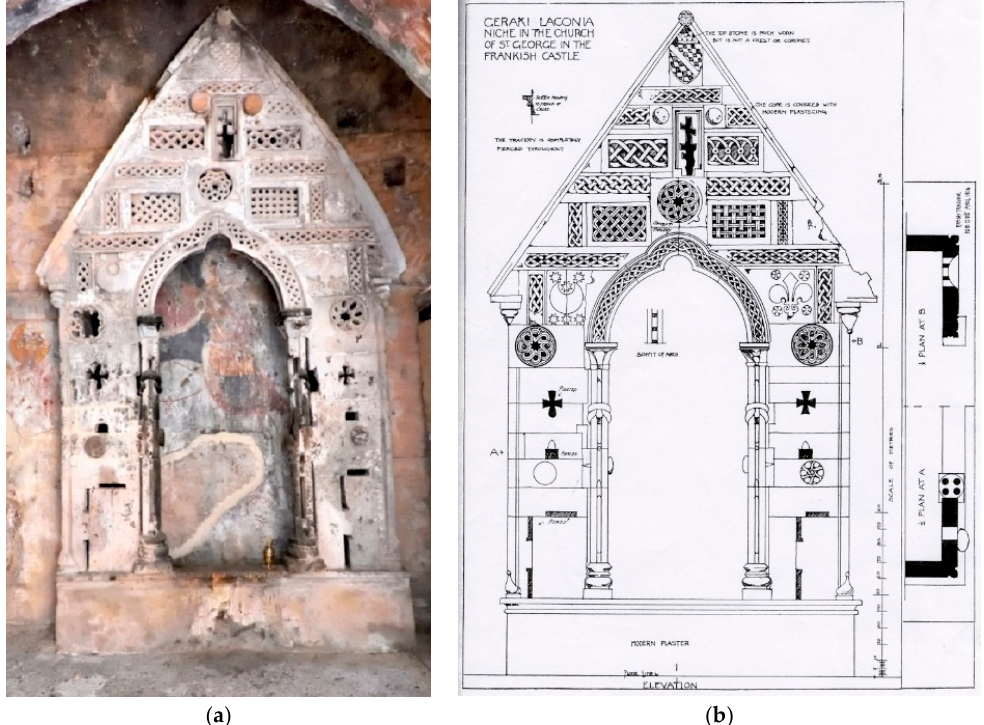
Figure 34. Stone gabled aedicule ( proskynetarion or tomb?) with a depiction of St George, chapel of Hagios Georgios in the castrum of Geraki, north aisle, 1378–1381 (?). ( a ) General view © Used with permission of the Ephorate of Antiquities of Lakonia, Hellenic Ministry of Culture and Sports/Archaeological Resources Fund; ( b ) drawing. Source: (Traquair 1905–1906).